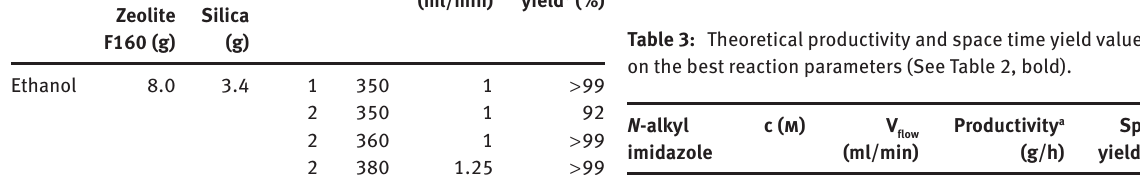
Alcohol Catalyst